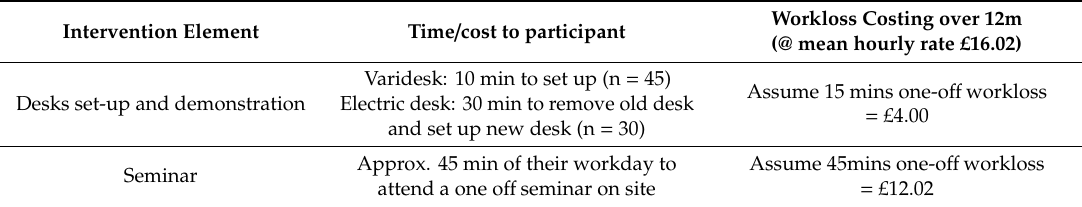
Table 2. Participant time spent on intervention and estimated workloss